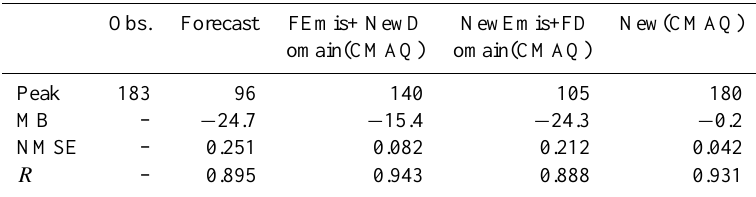
Table 2. Statistical measures of the modelled NSAQ station-averaged PM 10 -API in Beijing. Obs. Forecast FEmis+ NewD NewEmis+FD New(CMAQ) omain(CMAQ)